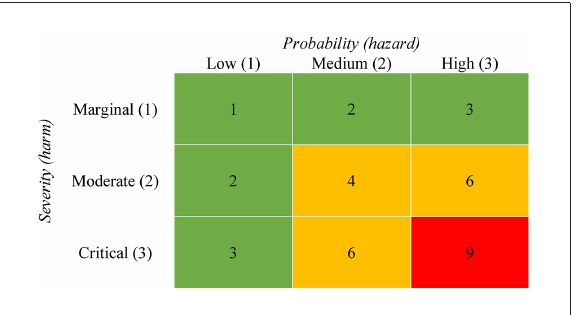
FIGURE1 Exemplary illustration of a risk matrix. The numbers in cells quantify the risk for a harm by multiplying the two axes. The grid is divided into three different risk categories. Green indicates a low, yellow a medium and red a high